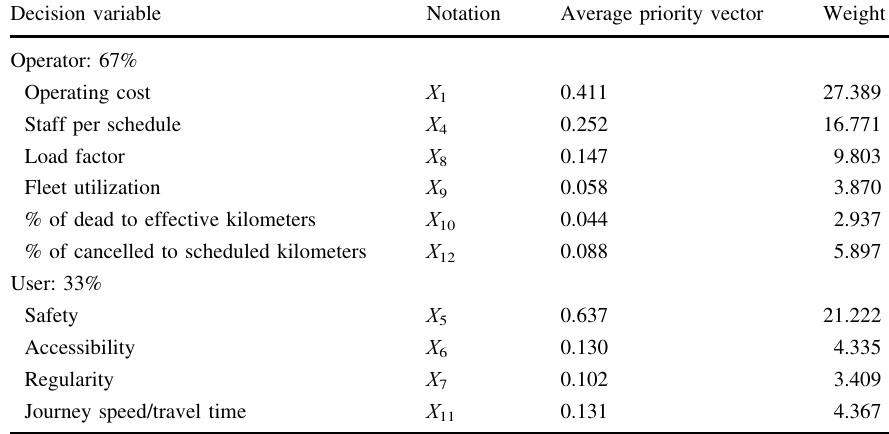
Table 6 Final weights of decision